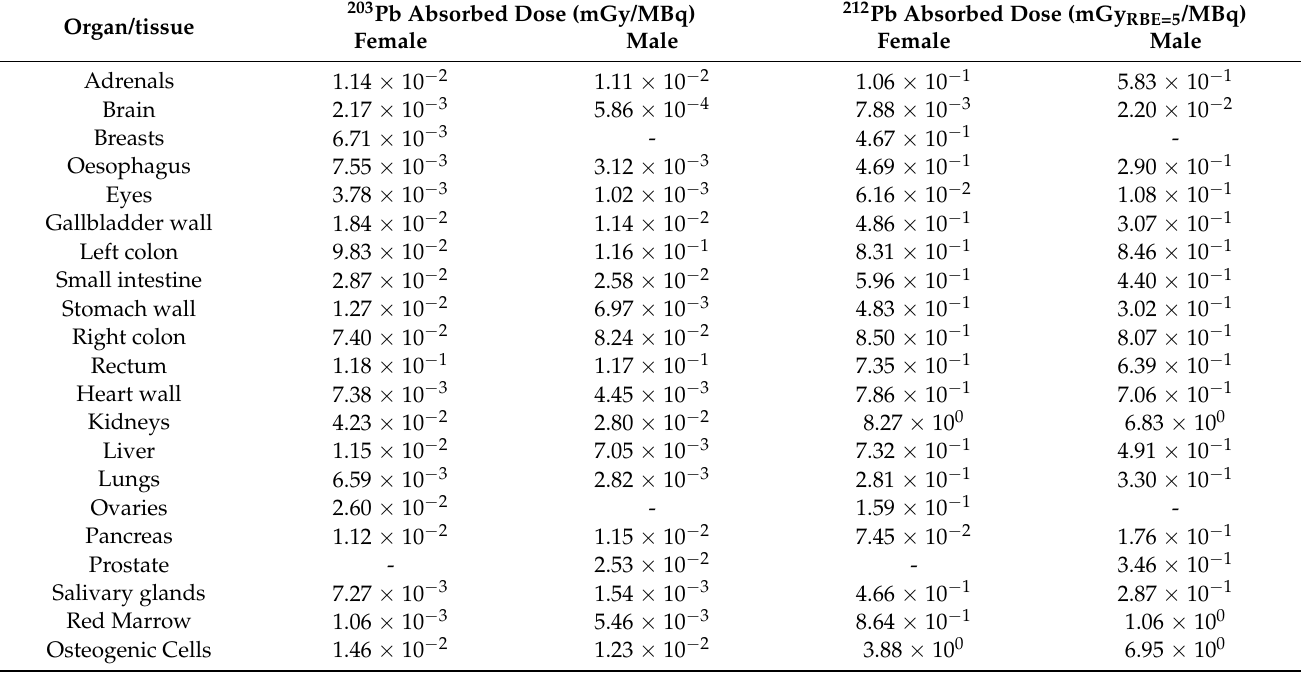
Table 2. Human tissue absorbed